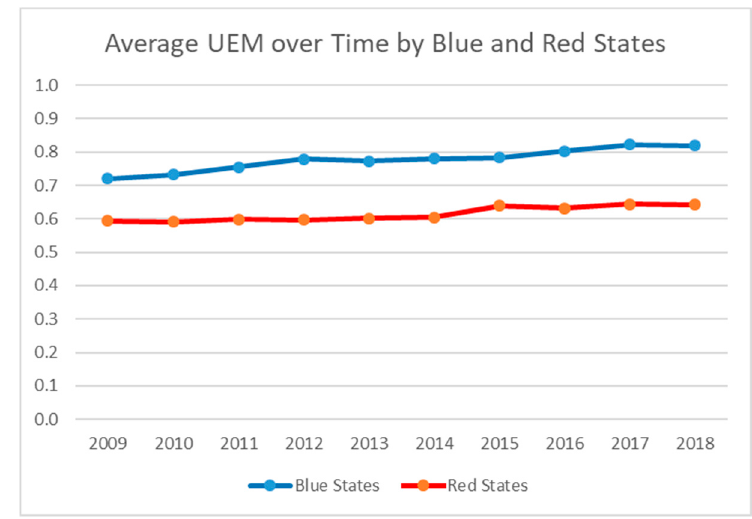
Figure 2. Average Unified Efficiency Scores of Blue and Red States from 2009–2018.